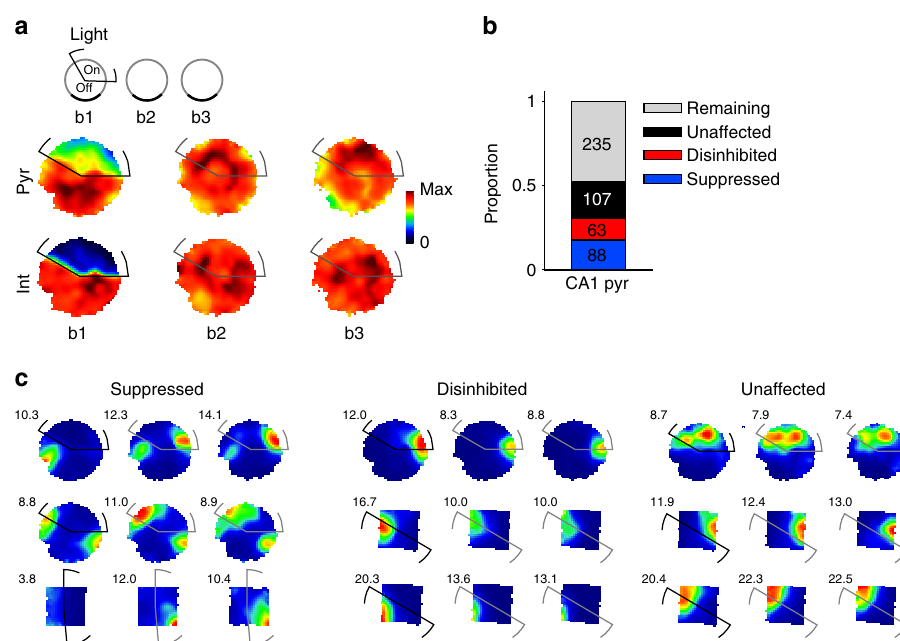
Figure 5 | Manipulation of CA1 activity in novel environment. ( a ) Top: simplified schematic showing the three exposures to the novel environment (b1–b3) during the novel experimental paradigm. The laser light was triggered when the animal entered a specific part of the arena (‘light zone’; b1). Sessions lasted 25min separated by 25min sleep/rest in a sleep box. Bottom: cumulated firing maps for pyramidal cells and interneurons in a representative recording session. ( b ) Proportions and cell numbers for different cell categories. Only cells passing place cell criteria in sessions b2 and/or b3 were included in the analysis. Total CA1 pyramidal cells in novel paradigm, n ¼ 493 in 9 recording days in 4 animals. ( c ) Firing maps of example place cells. Numbers on the top left note the top firing rate of the cells on the map